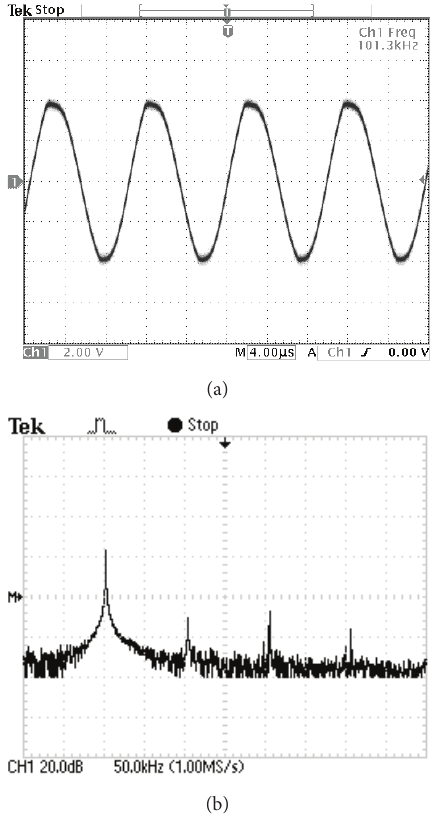
Figure 7: Experimental results for the circuit (Figure 4(b)): (a) output waveform and (b) corresponding frequency spectrum.